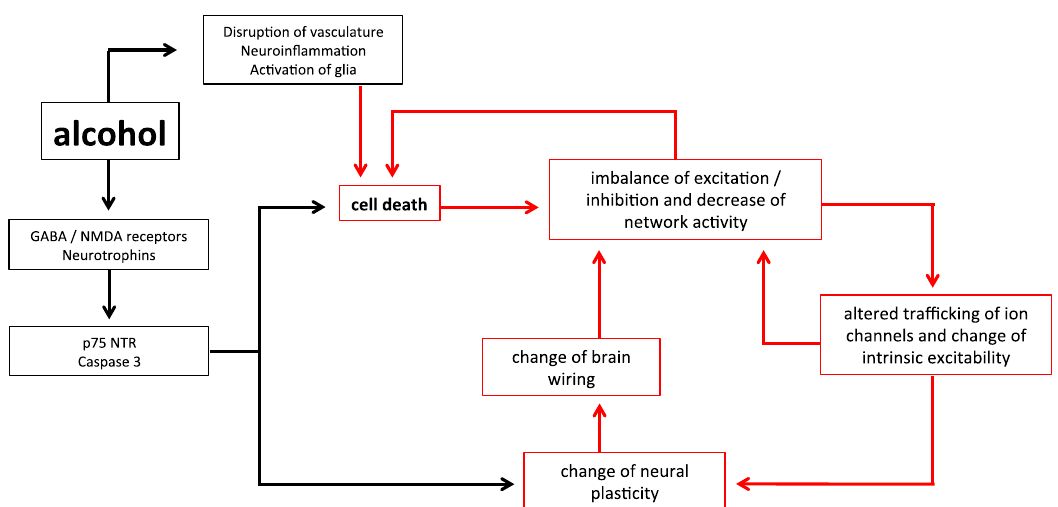
Figure 1. A schematic of the relationships between early alcohol exposure and cell death. Alcohol has immediate impacts upon the system which can lead to an increased apoptosis different from natural programmed cell death, yet also results in plastic changes to the brain. This can lead to a further imbalance of the system in terms of inhibition/excitation and cell excitability, creating a vicious cycle likely to result in further abnormal apoptosis. Critically, the impact of alcohol on all these factors is mediated by the duration of exposure, and the time of exposure in the developmental